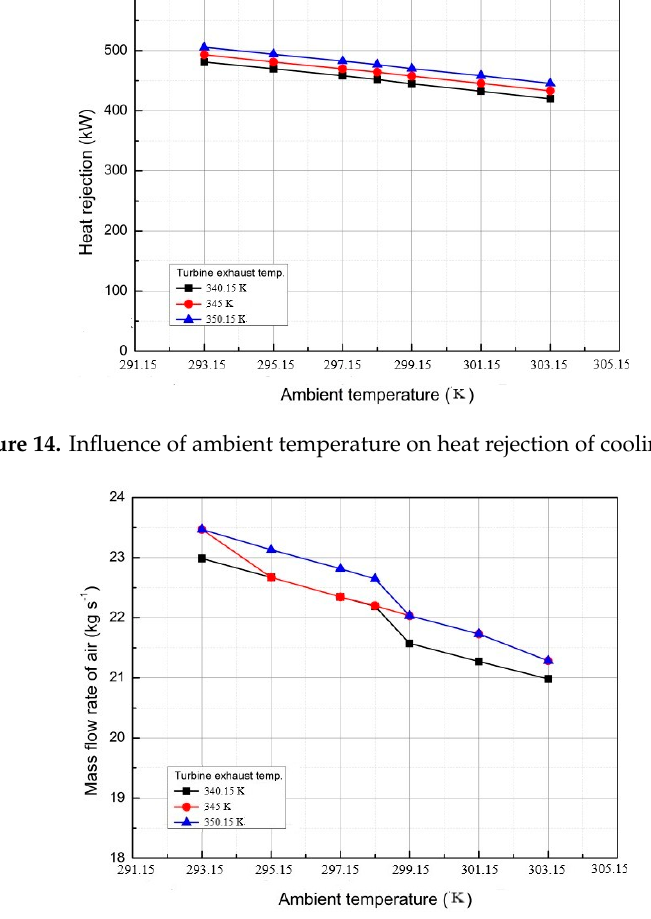
Figure 15. Mass flow rate of air through the cooling tower at different ambient temperatures.